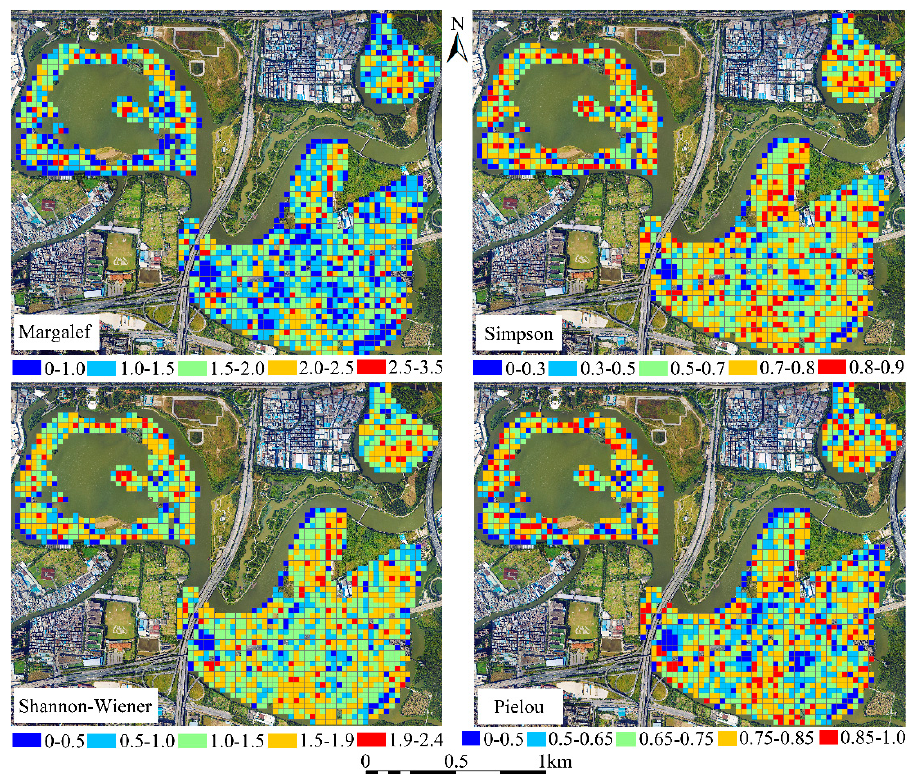
Figure 5. Tree species diversity mapping with a spatial resolution of 30 m in the three parts of Haizhu Wetland.